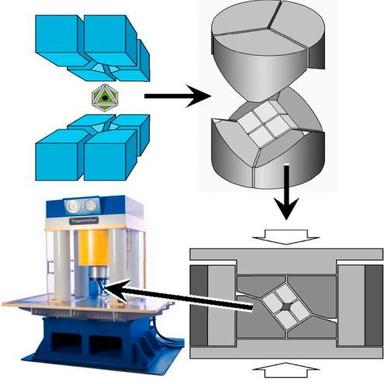
Large volume press (LVP) with Walker-module configuration.